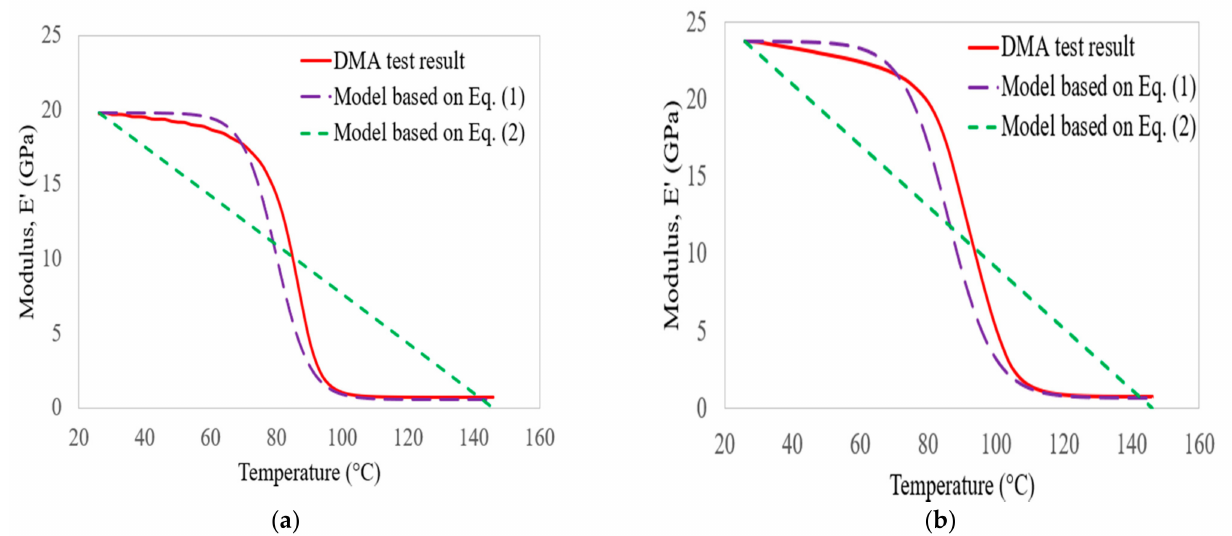
Figure 11. Comparison of glass–carbon laminate storage modulus results with empirical models at 1 Hz ( a ) and 100 Hz ( b